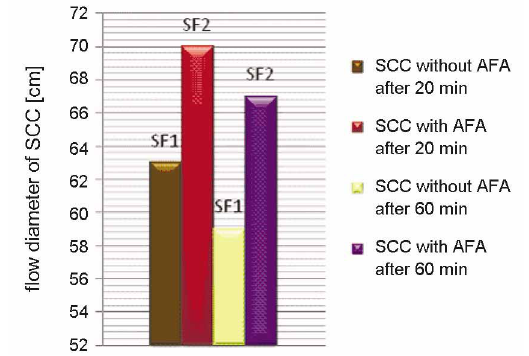
Fig. 14. The loss of initial consistency of SCC with and without AFA. Symbols SF 1 and SF2 represent slump-flow classes according to Table